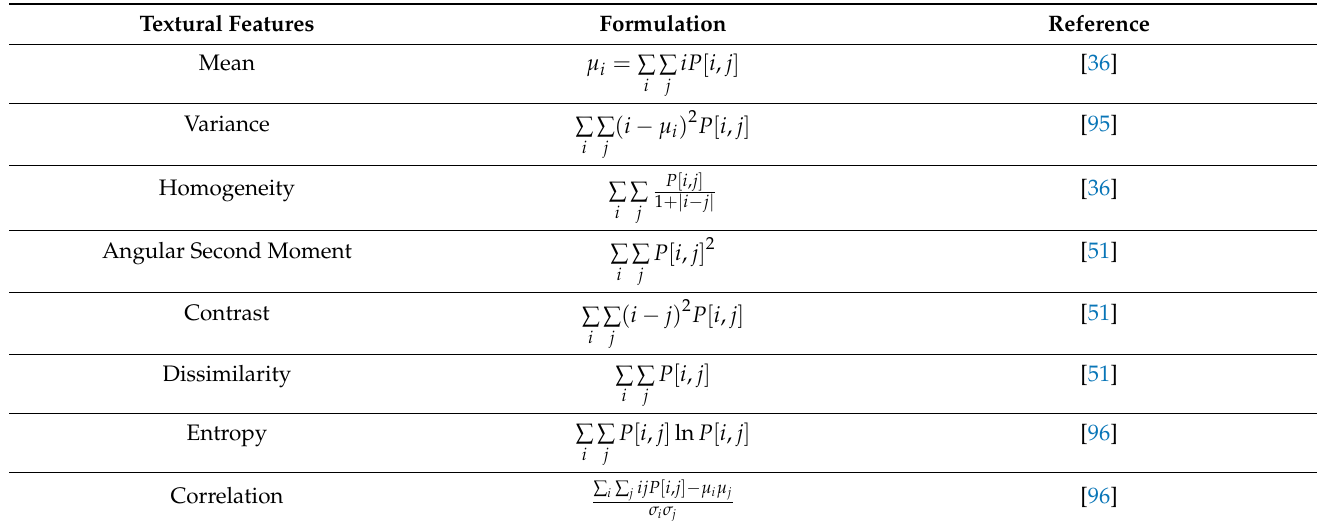
Table A2. Textural features extracted for